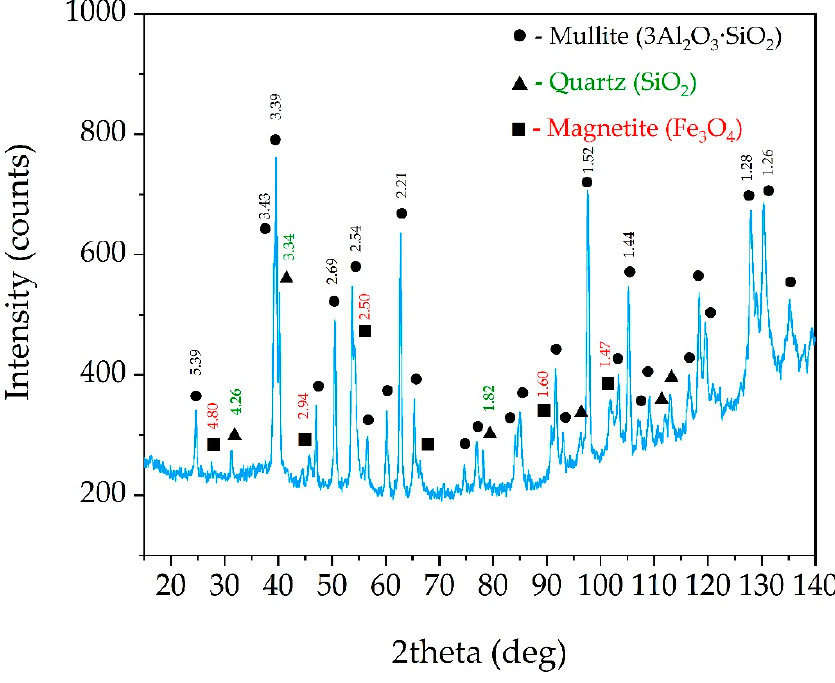
Figure 7. XRD pattern of the solid residue obtained after NaOH leaching at T = 110 ◦ C, L / S ratio = 21.5, τ = 75 min (the numbers above the peaks refer to d-spacing).